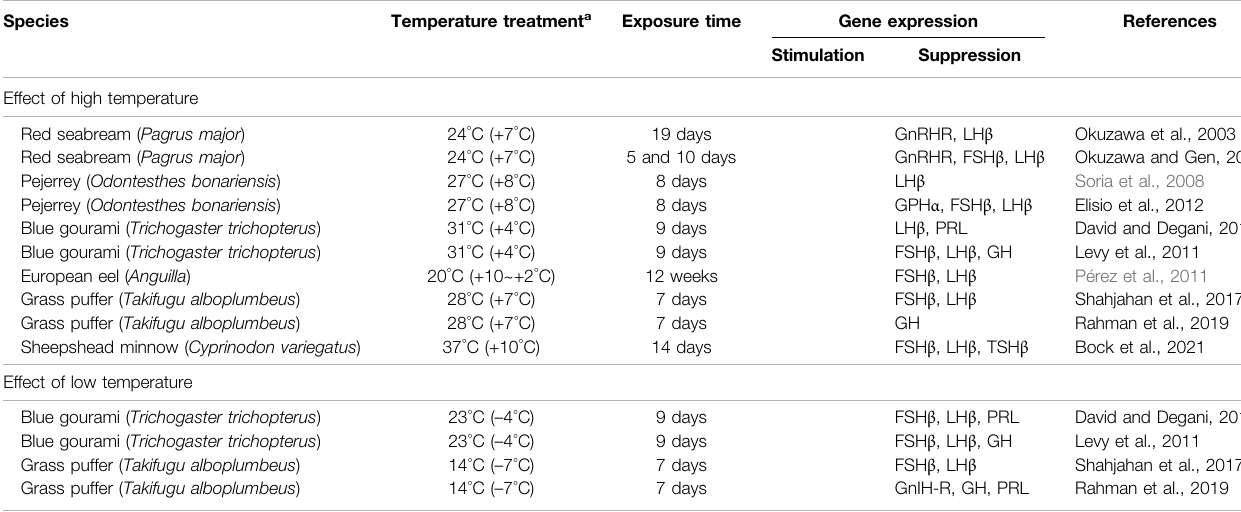
TABLE 2 | Effects of water temperature on the pituitary of fi sh.